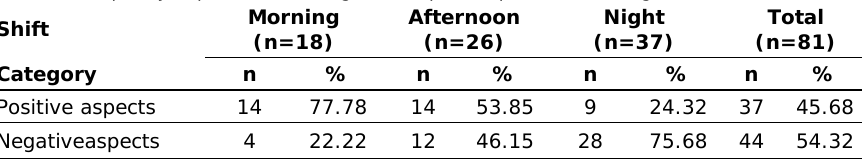
Table 3. Frequency of positives and negatives aspects, opinions according to shift and overall.